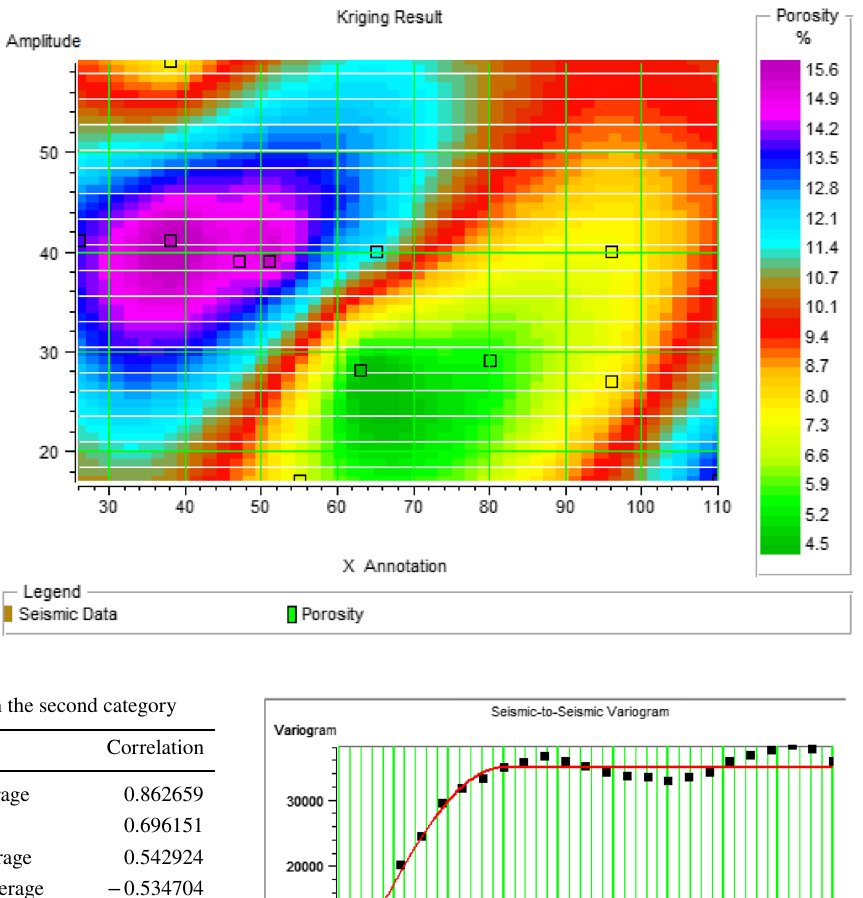
Fig. 26 Porosity obtained from ordinary kriging using structure obtained from well data in the